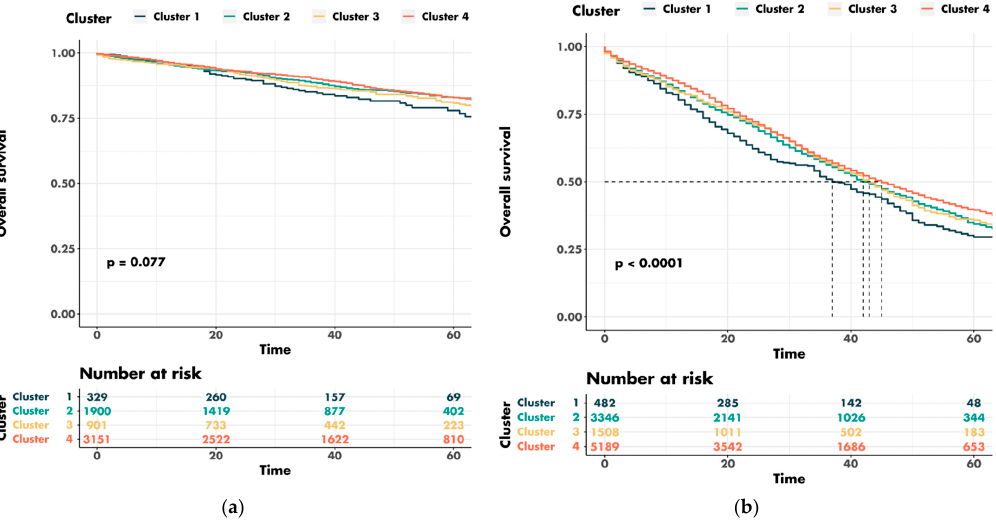
Figure 6. Univariable survival analysis for county clusters stratified for cancer stage: ( a ) early stages; ( b ) advanced stages.